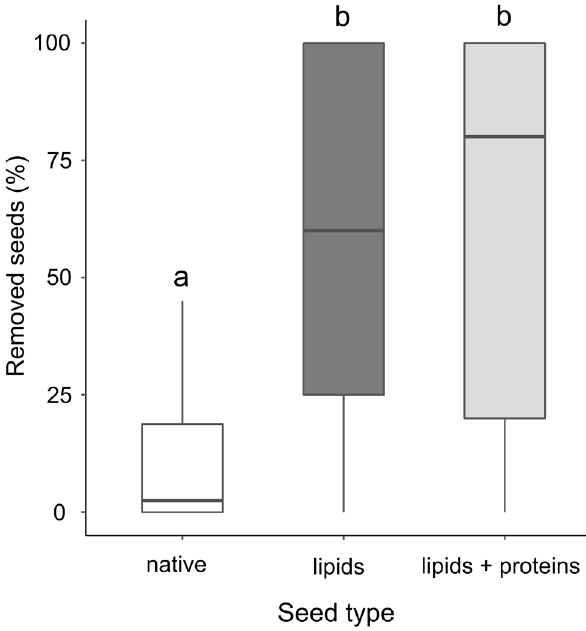
Fig 2. Proportion of removedseeds by Pogonomyrmex barbatus (Myrmicinae). Native seed = Opuntiapilifera (Cactaceae). Lipids = artificial seeds with lipids (9% of the content). Lipids + proteins= artificial seeds with lipids + proteins (9% and 6% of the content, respectively). The lines represent the first and four quartiles, the box represents the second and first quartiles and the line within the box represents the median of each treatment. Boxplots with different letters represent significant differencesaccording toWald χ 2